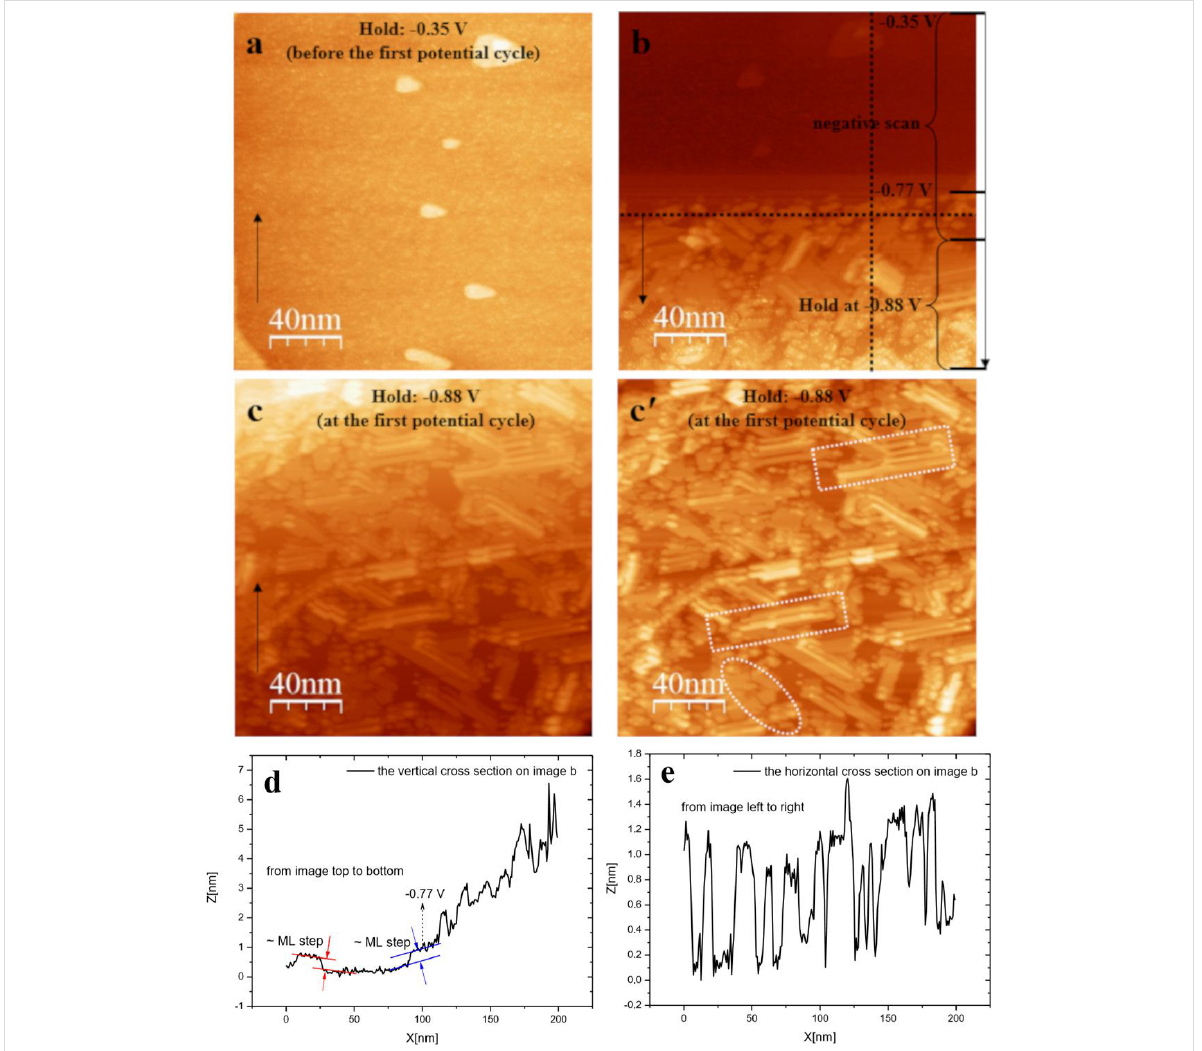
Figure 7: STM images of Sb overpotential deposition on Au(111) during the first potential cycle in 0.25 mM Sb 2 O 3 /0.5 M H 2 SO 4 electrolyte. (a) Initial Au(111) surface at the potential of − 0.35 V. (b) The electrode potential was scanned negatively from − 0.35 to − 0.88 V and then stopped at − 0.88 V. (c, c') The electrode potential was held at − 0.88 V. (d) The cross section of image b (black vertical dotted line). (e) The cross section of image b (black horizontal dotted line). Sample bias = 50 mV, set point = 0.5 nA and scan rate = 3.04 ln/s. Integral gain: 6 and proportional gain: 8. The arrows indi- cate the scan direction. Plane correction was used for images a, b and c. Line-by-line correction was used for image c'.